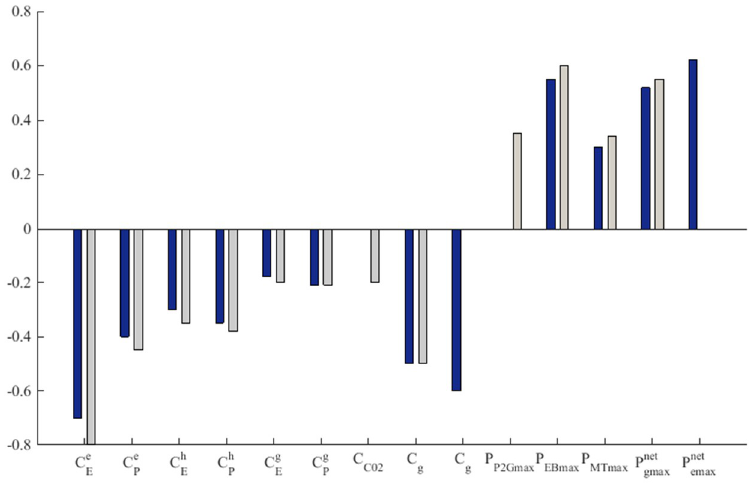
Figure 6. The quantified sensitivity factor results. 509